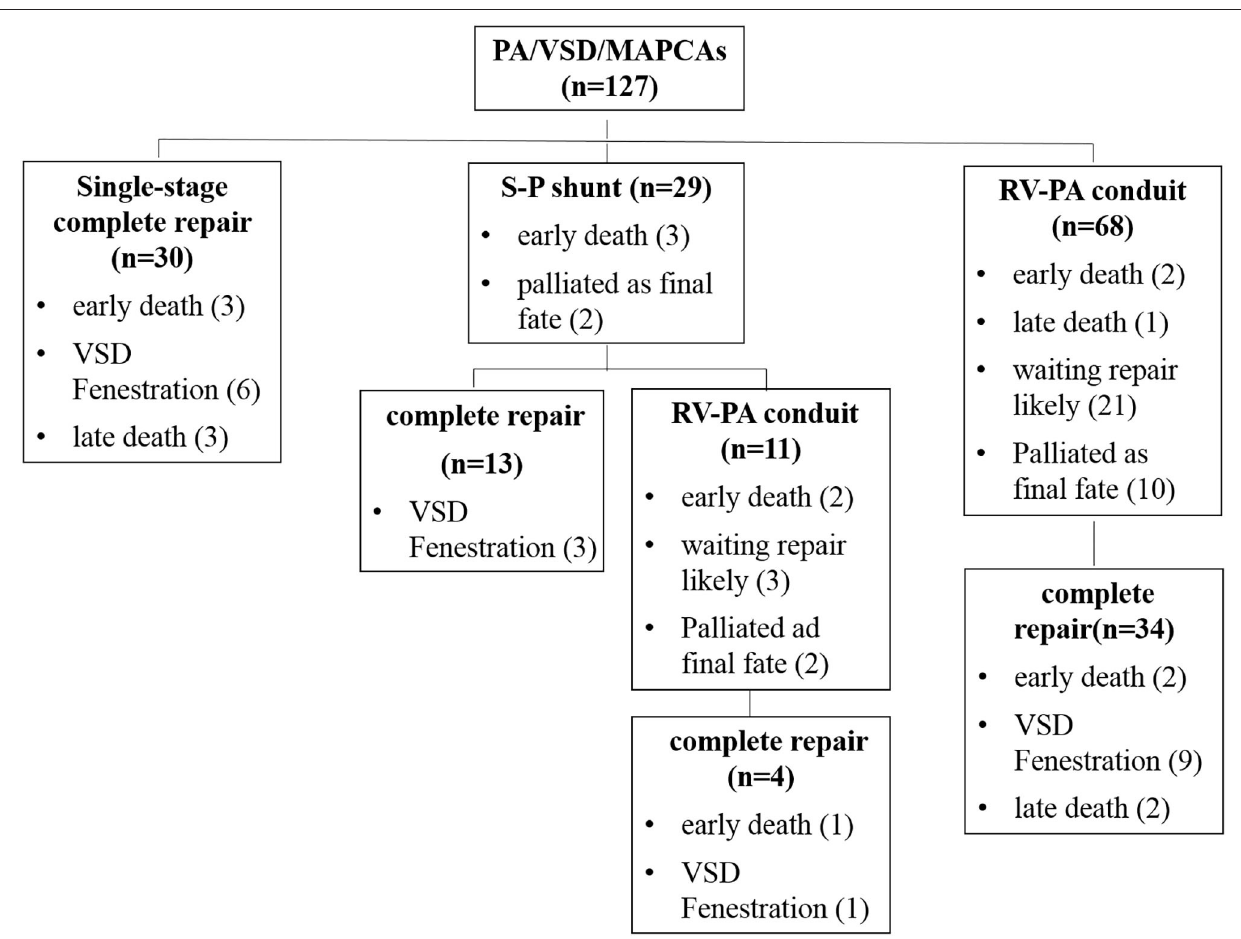
Frontiers in Cardiovascular Medicine |